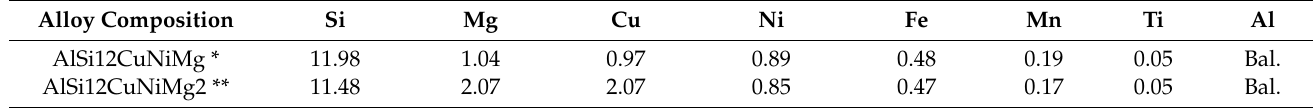
Table 1. Chemical composition 1 of EN AC 48000 (AlSi12CuNiMg) commercial alloy * and modified by adding 1% Mg